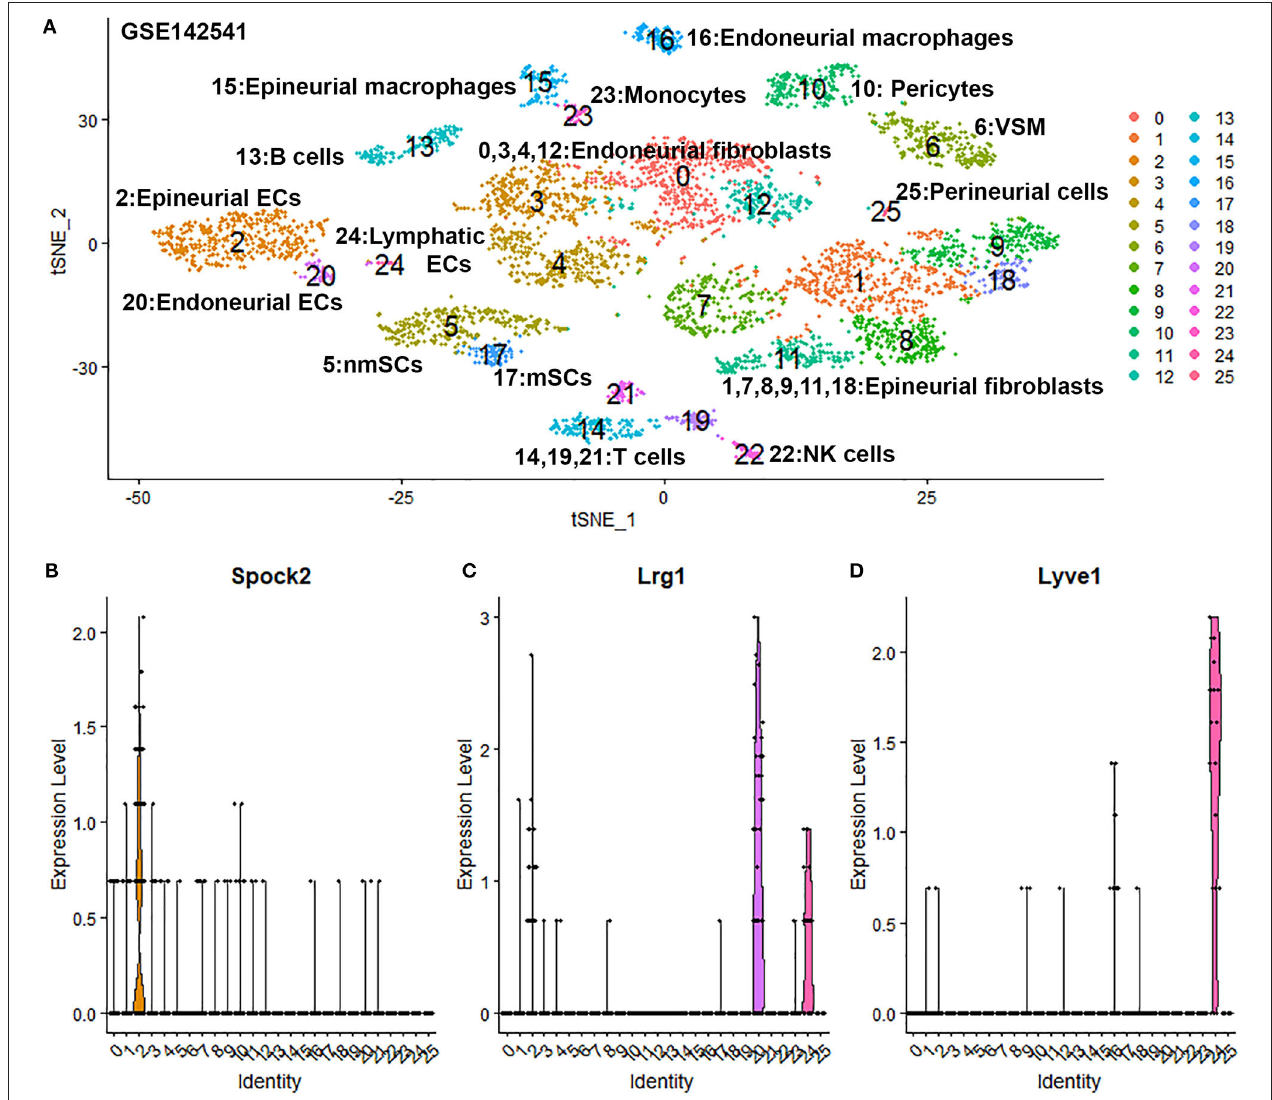
FIGURE 6 | Single cell transcriptomics (GSE142541) defines cellular phenotypes in intact mouse sciatic nerve and the brachial nerve plexus. (A) tSNE visualization of 26 cell clusters in intact mouse sciatic nerve at resolution 1.35. (B) Violin plot showing Spock2 expression in the epineurial EC cluster (cluster 2). (C) Violin plot showing Lrg1 expression in the endoneurial EC cluster (cluster 20). (D) Violin plot showing Lyve1 expression in the lymphatic EC cluster (cluster